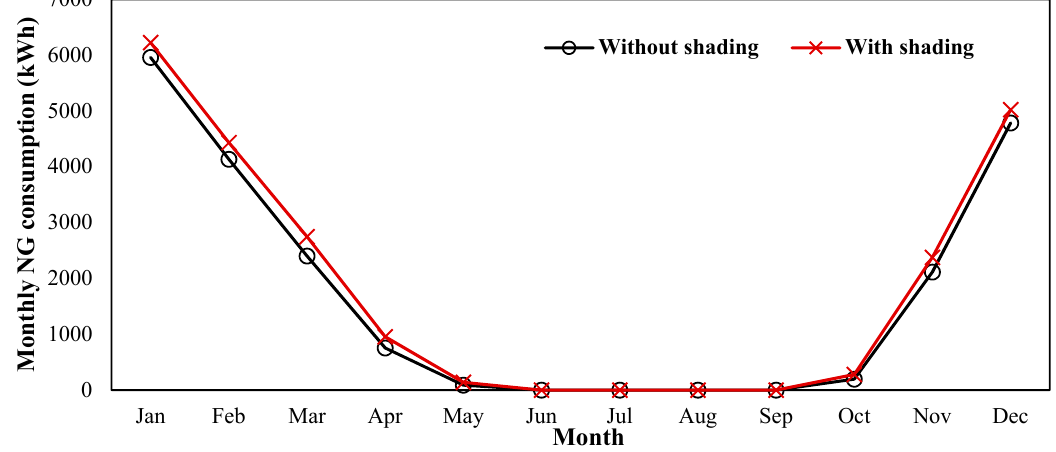
Figure 13. Monthly NG consumption with and without shadings.